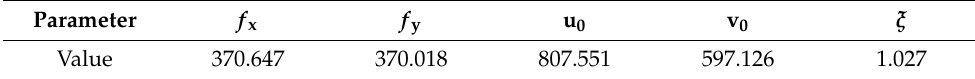
Table 3. Calibration